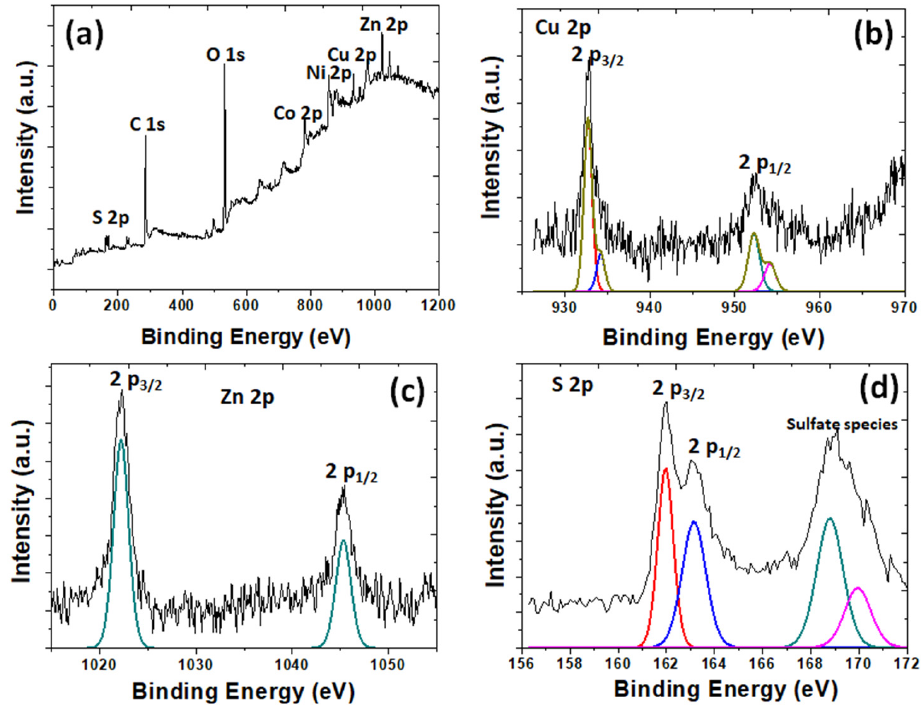
Figure 8. XPS spectra of the as-prepared CuZnS QDs decorated (NiCo)–S@rGO/oxdCNT composite: ( a ) survey spectra, ( b ) Cu 2p, ( c ) Ni 2p and ( d ) S 2p.